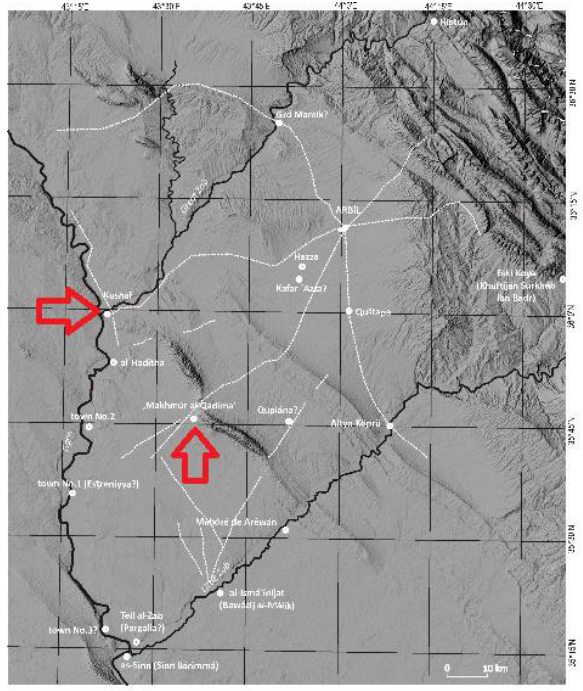
Figure 1 - Area of interest map with detected historical